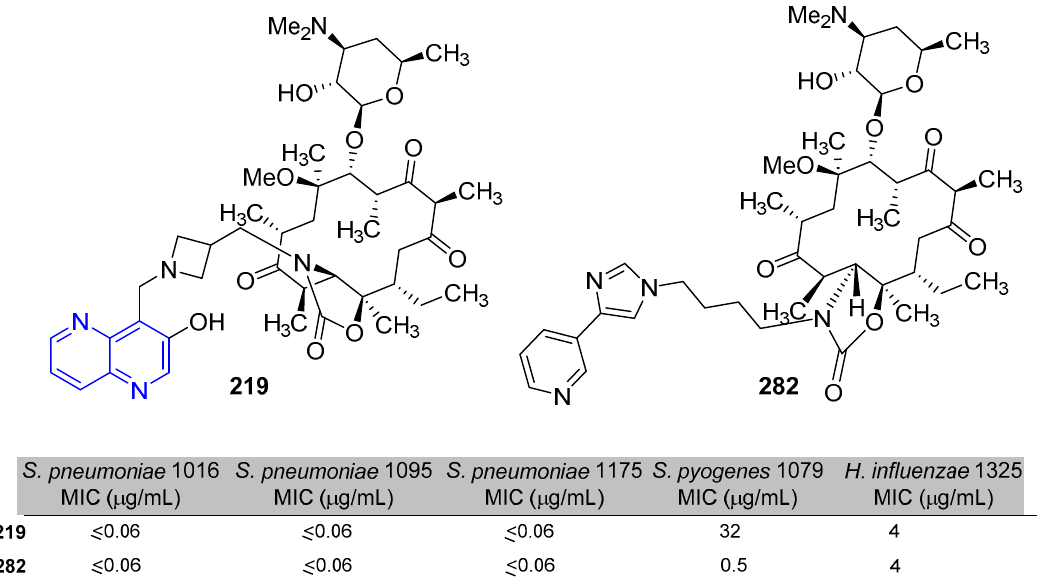
Figure 14. Antibacterial activity of 1,5-naphthyridine-containing macrolides.